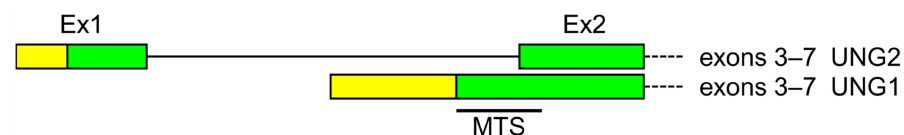
Figure 1. Organization of the alternative transcription initiation in the human UNG gene. Untranslated regions are yellow, coding sequences are green. MTS—mitochondrial targeting